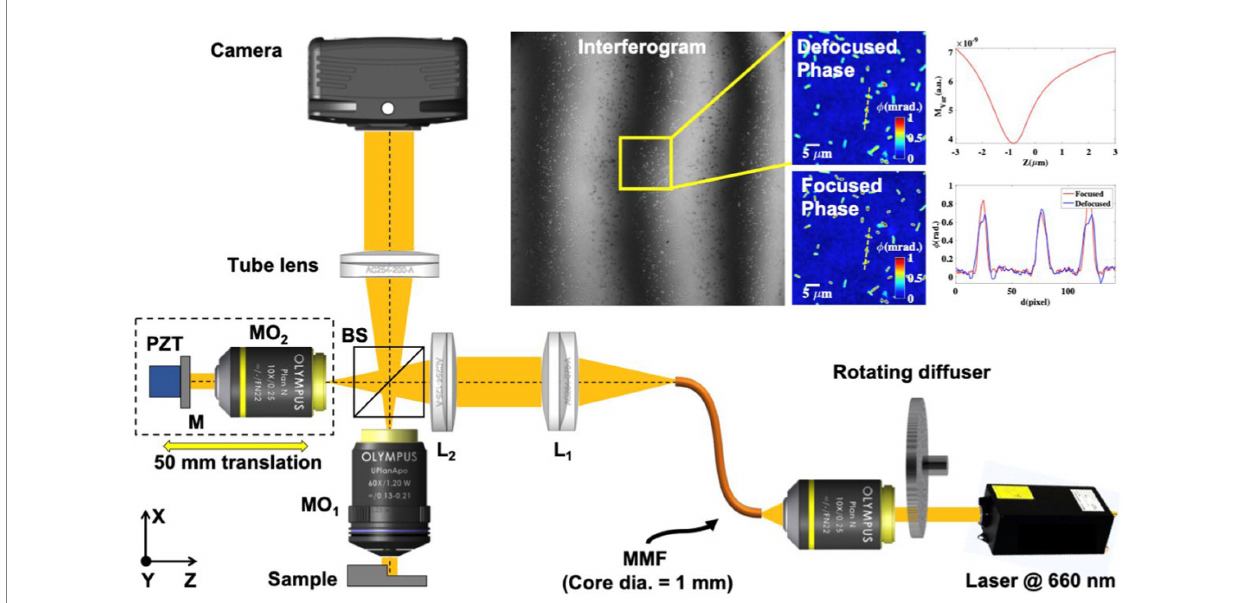
FIGURE 1 Optical schematic diagram of Linnik interferometer-based QPM setup. MO1-2, microscope objectives; BS1-2, beam splitters; L1-2, achromatic doublet lenses; MMF, multi-mode fiber; M, mirror; and PZT, piezo electric transducer. The inset represents the interferogram, reconstructed defocused phase map, numerically focused phase map, and amplitude variance plot of the numerically propagated optical field as a function of the propagation distance. The line profiles of the bacteria phase map before and after focus correction along the yellow dotted